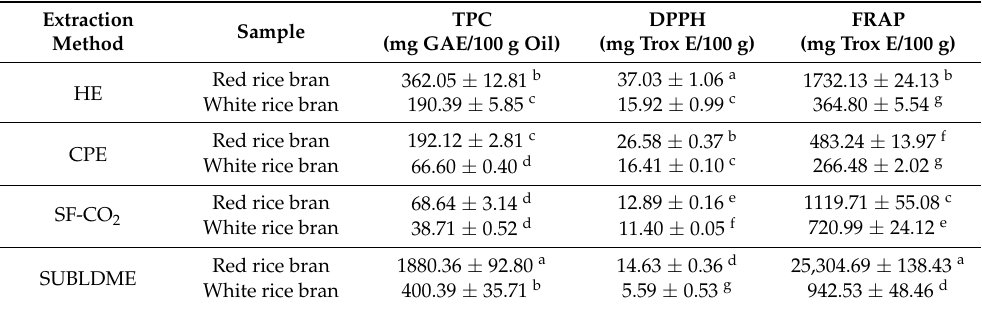
Table 4. Total phenolic, DPPH radical scavenging abilities, and ferric reducing antioxidant power of crude rice bran oil extracted by various extraction